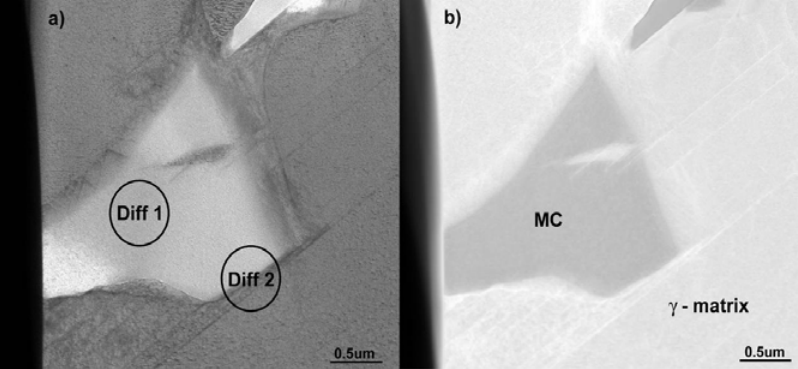
Figure 5. Microstructure of a MC: ( a ) Scanning Transmission Electron Microscpy in Bright Field (BF-STEM); and ( b ) Scanning Transmission Electron Microscpy in High-Angle Annular Dark Field (HAADF-STEM).